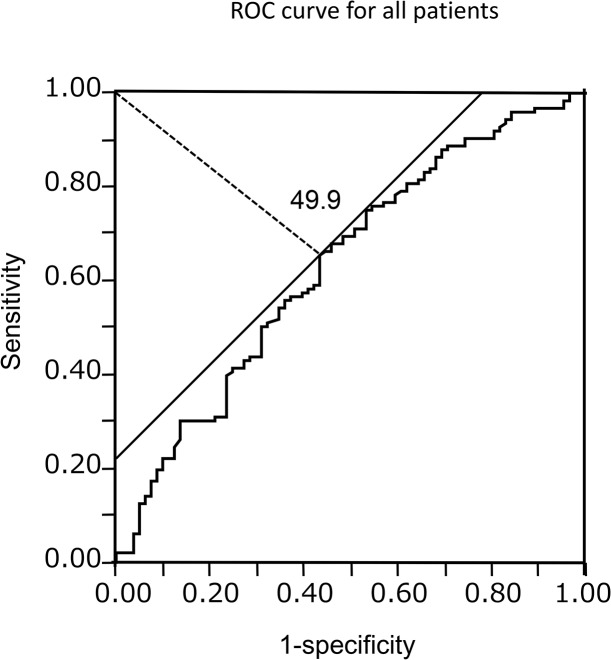
Receiver operating characteristic curve in all patients.Optimal cut-off for the prognostic nutritional index was 49.9 (Area under the curve = 0.63).